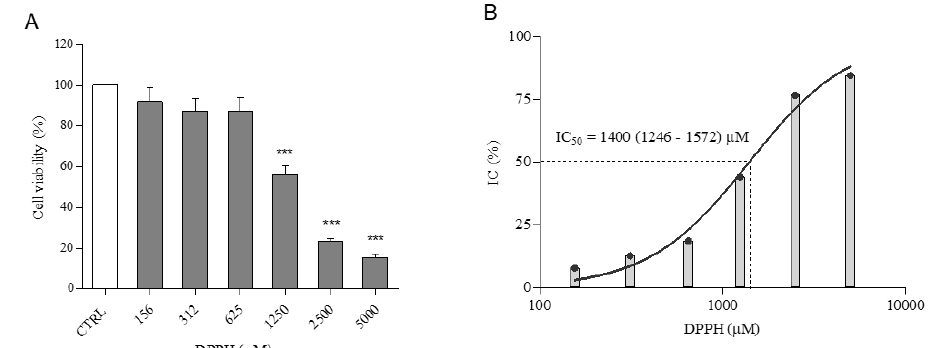
Figure 1. Cell viability of PNT2 treated with DPPH. ( A ) Dose–response curve of DPPH on cell viability of PNT2. Cells were treated with six concentrations of DPPH (156, 312, 625, 1250, 2500 and 5000 µM) for 24 h. The results are expressed as percent of cell viability calculated as the ratio between mean absorbance of each treatment and mean absorbance of control. ( B ) Inhibitory Concentration (IC) of viability data, expressed as a percentage. All values are represented as the mean ± SD of three independent experiments. Asterisks indicate the statistically significant difference compared to a negative control (*** p ≤ 0.001; Dunnett’s test).